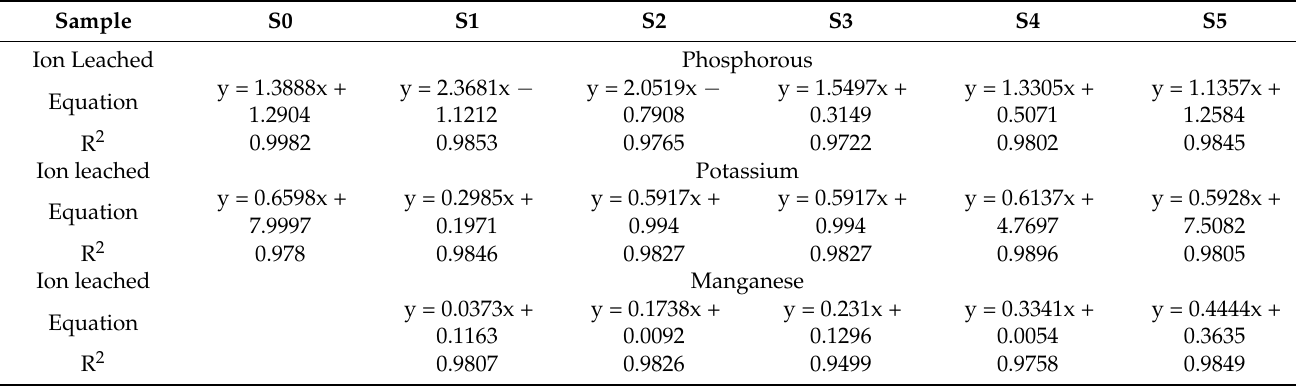
Table 3. Linear regression equations and corresponding coefficients of determination for ions leaching